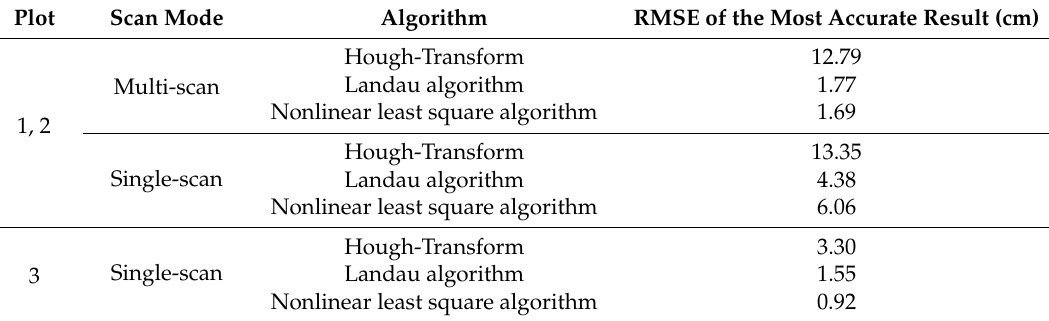
Table 3. Root Mean Square Error (RMSE) of the most accurate result for each algorithm in different plots and scan modes. Plot Scan Mode Algorithm RMSE of the Most Accurate Result